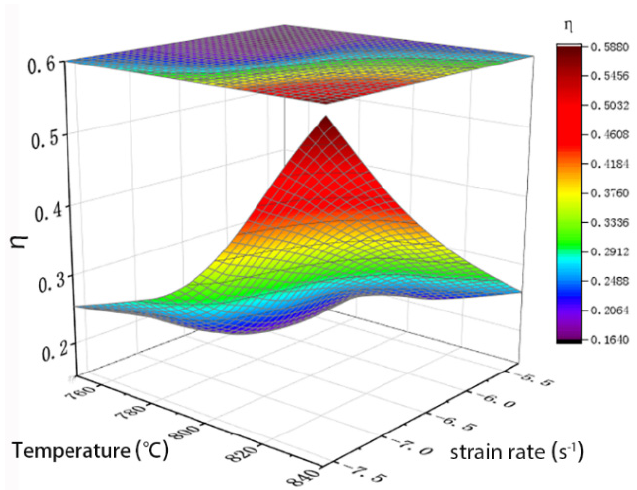
Figure 8. Energy dissipation of Ti-6Al-4V. The energy dissipation rate (red areas in Figure 8) of this alloy at 790–810 ◦ C, and the strain rate of 5 × 10 − 4 –10 − 3 s − 1 , was very large and exceeded 50%. At this moment, the strain rate sensitivity index m, grain size index p, and deformation to failure δ of this alloy were all very large, which indicate the energy dissipation characteristics of this alloy during superplastic deformation. It is known from Figures 6 and 7 as well as the 3D projection in the upper part of Figure 8 that the turning point on the power dissipation curve indicates the occurrence of dynamic